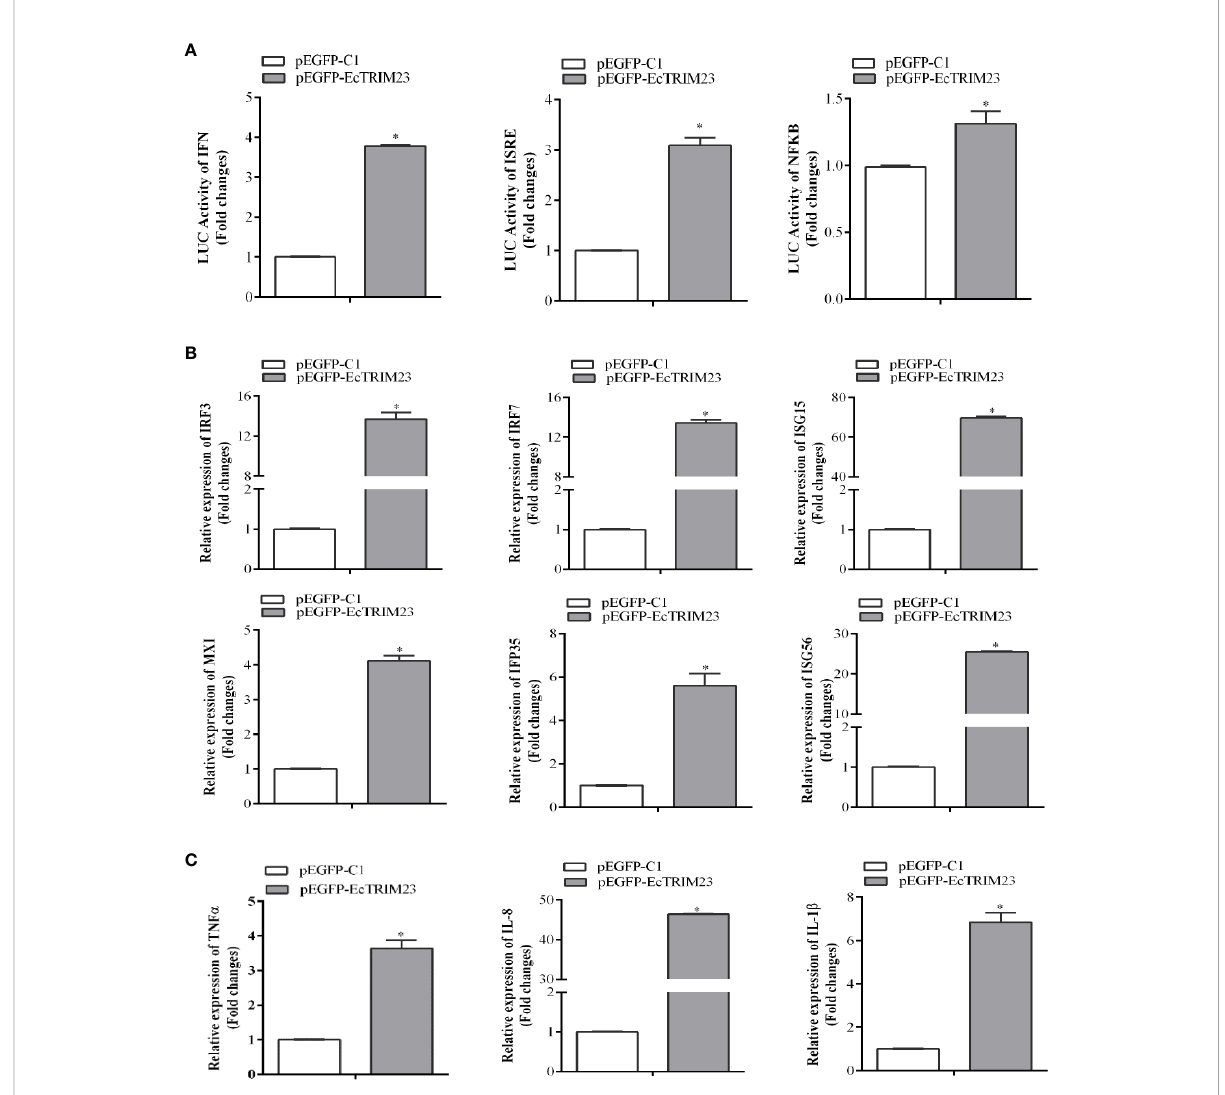
FIGURE 4 The effects of EcTRIM23 overexpression on host immune response. (A) The effects of EcTRIM23 on the promoter activities of IFN, ISRE and NF- k B. GS cells were co-transfected with pEGFP-EcTRIM23 and ISRE-Luc, IFN-Luc, or NF- k B-Luc for 48 h, respectively. Cell were lysed, and the luciferase activities were measured using the dual-luciferase reporter assay. (B, C) The effects of EcTRIM23 overexpression on the transcription levels of interferon-related genes (B) and pro-in fl ammatory factors (C) . GS cells were transfected with pEGFP-EcTRIM23 or pEGFP-C1, and then the cells were collected at 48 h for qPCR analysis. The expression levels of IRF3, IRF7, ISG15, IFP35, MXI, ISG56, TNF- a , IL-1 b , and IL-8 were determined by qPCR, respectively. * p <